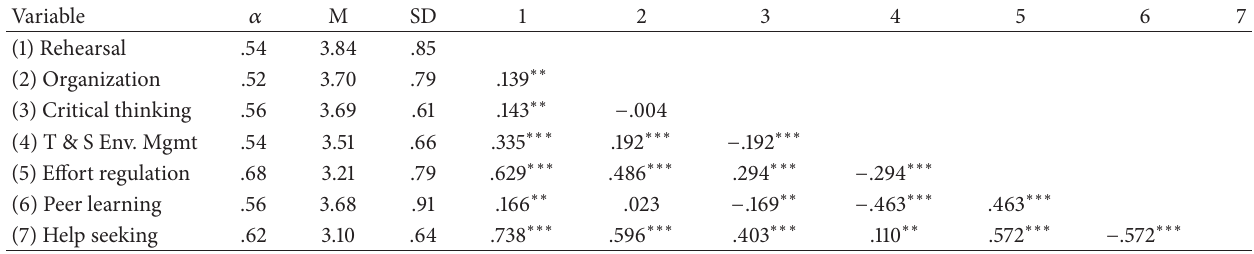
Table 2: Coefficient alphas, means, mean differences, and one-way repeated-measures ANOVA pairwise comparison results for learning strategies of participants. Variable